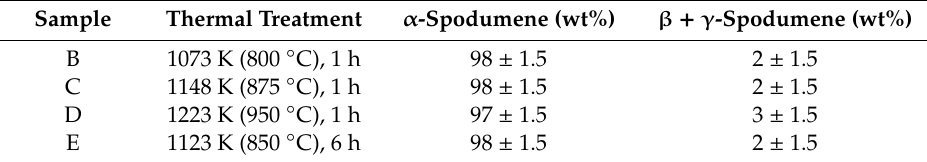
Table 3. Rietveld analyses on low-temperature heat-treated